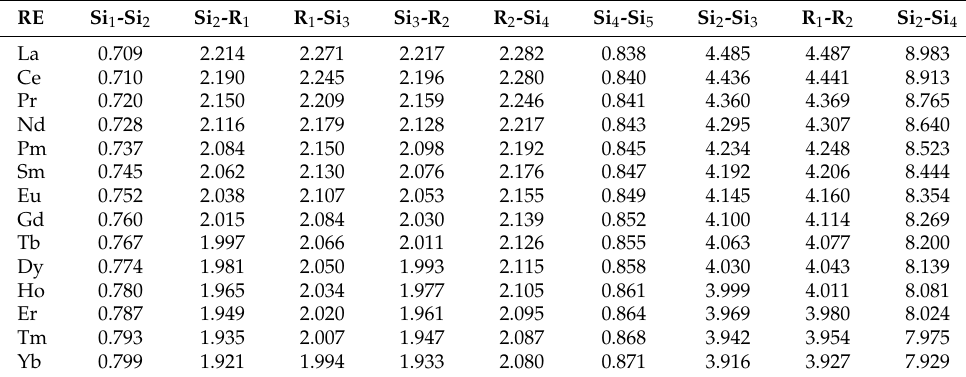
Table 4. Atomic layer distances (in Å) calculated by DFT-PBEsol for the silicide bilayer structure √ √ with ( 3 × 3) periodicity for different rare earths. Labels as defined in Figure